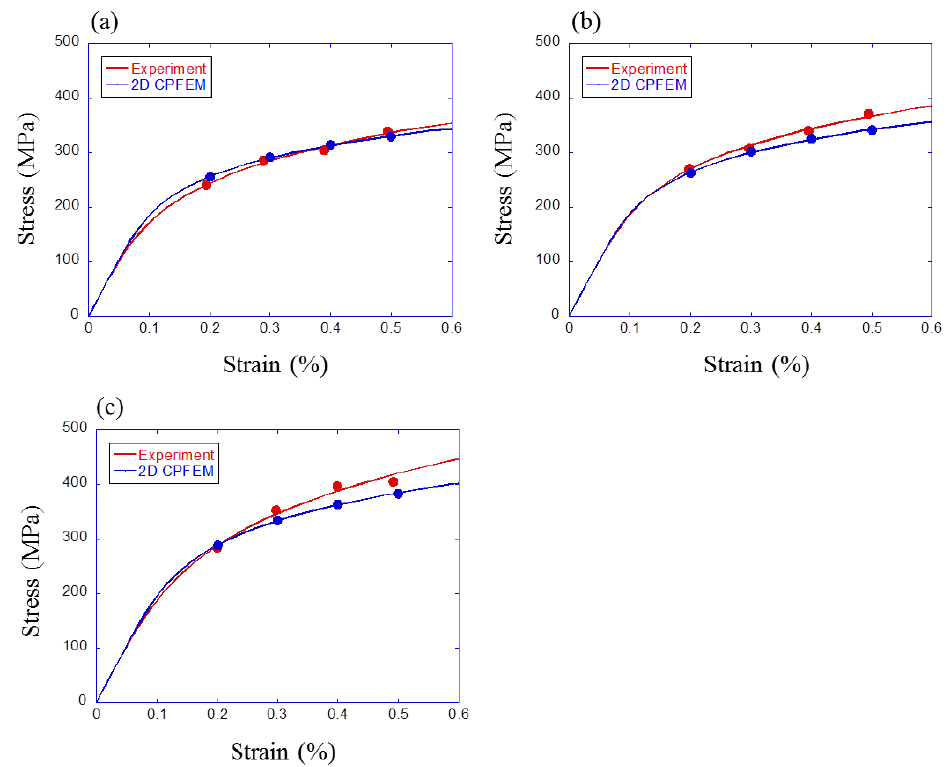
Figure 9. Experimental and simulated cyclic stress–strain curve for ( a ) S25C, ( b ) S35C, and ( c ) S45C.